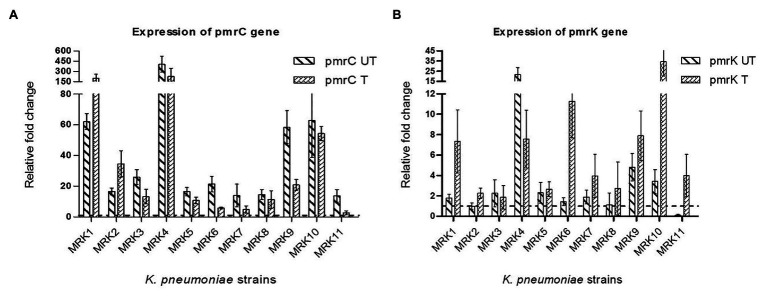
Fold changes ±SD in the expression of pmrC and pmrK genes among colistin-resistant K. pneumoniae isolates (n = 11) with respect to colistin-susceptible K. pneumoniae ATCC 700603 isolate are represented here. The rpsl gene was used as internal control. All the reactions (both under colistin treated and untreated conditions) were normalized using colistin-susceptible K. pneumoniae ATCC 700603 (colistin untreated- wild type). (A) relative fold-change of pmrC gene expression under colistin treated (pmrC T) and untreated conditions (pmrC UT); (B) relative fold-change of pmrK gene expression under colistin treated (pmrK T) and untreated conditions (pmrK UT). Values given are mean ± SD of three different experiments with qRT-PCR reactions performed in triplicate.